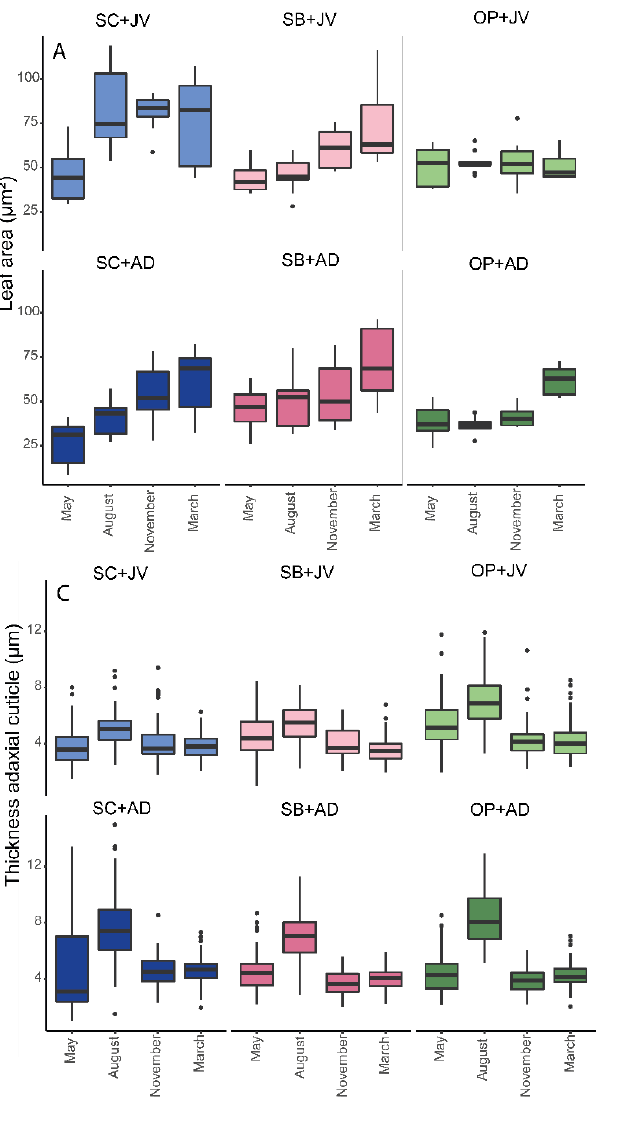
Figure 3. Morphoanatomical traits measured in juveniles and adults of R. mangle during four periods. SC + JV: Smith Channel juveniles, SB + JV: Sound Bay juveniles, OP + JV: Old Point juveniles, SC + AD: Smith Channel adults, SB + AD: Sound Bay adults, OP + AD: Old Point adults. ( A ) Leaf area. SC + JV: n = 36, SB + JV: n = 36, OP + JV: n = 36, SC + AD: n = 36, SB + AD: n = 36, OP + AD: n = 36. ( B ) Thickness leaf. SC + JV: n = 324, SB + JV: n = 324, OP + JV: n = 326, SC + AD: n = 325, SB + AD: n = 324, OP + AD: n = 320. ( C ) Thickness adaxial cuticle. SC + JV: n = 324, SB + JV: n = 324, OP + JV: n = 326, SC + AD: n = 325, SB + AD: n = 324, OP + AD: n = 320. ( D ) Thickness adaxial epidermis. SC + JV: n = 324, SB + JV: n = 324, OP + JV: n = 326, SC + AD: n = 325, SB + AD: n = 324, OP + AD: n = 320.